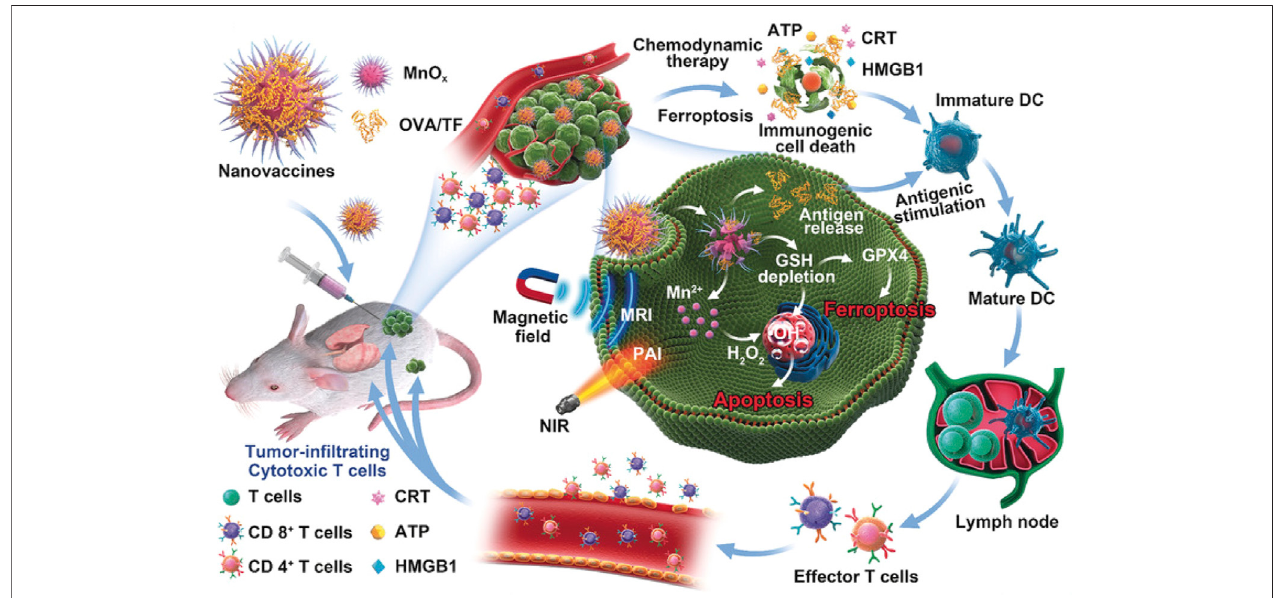
FIGURE 12 | Schematic illustration of MnOx-OVA/tumor cell fragment (TF) nanovaccines for MRI-/PAI-induced cancer immunotherapy. Adapted from Ding et al., (2020) Copyright @ 2020 (ACS).